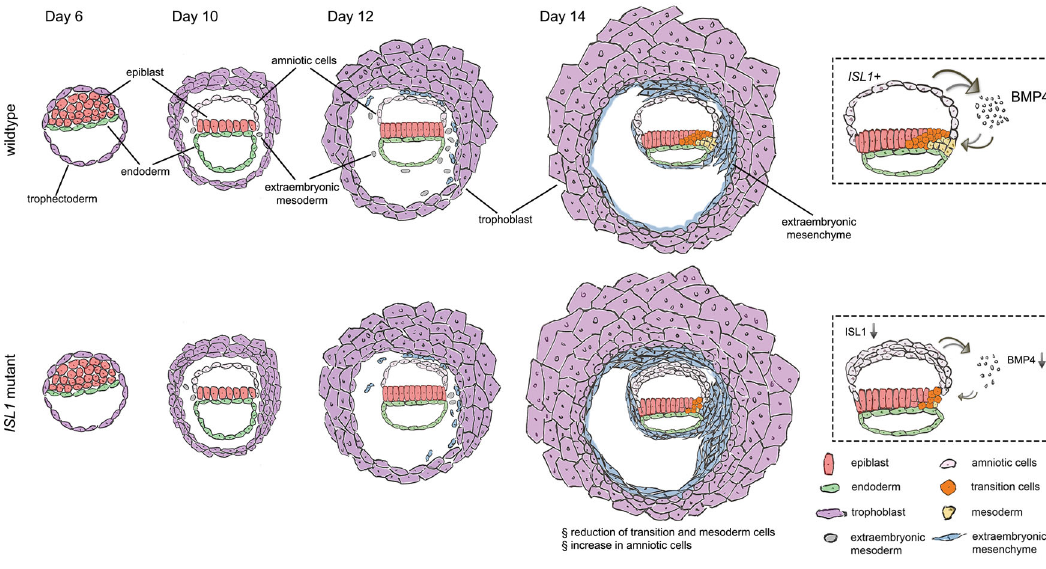
Fig. 7 A summary scheme depicting the embryogenesis of wild-type and ISL1 mutant embryos. In primate embryogenesis, the amnion forms a signaling center where ISL1 -dependent BMP4 signaling drives streak and mesoderm